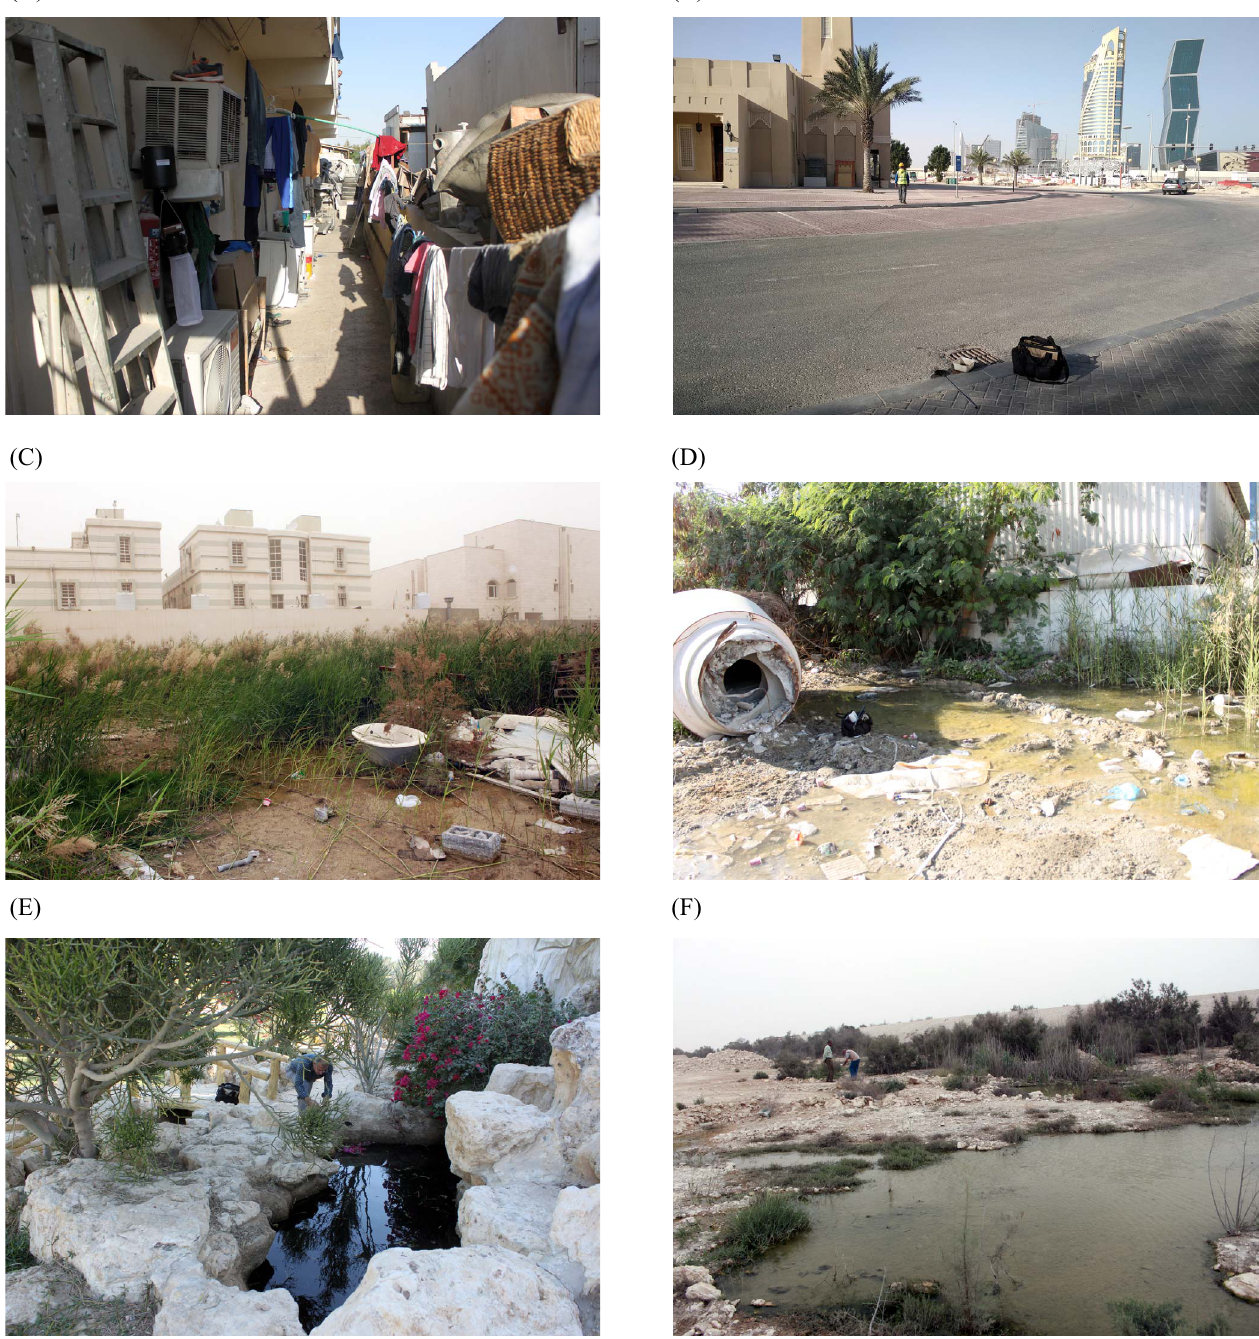
Figure 2. Examples of sites inspected for mosquitoes. A. Adult trapping at worker house, EVS trap (Q17c). Mosquito larval breeding sites: B. Road drain, breeding site for Culex quinquefasciatus (Q13); C. Flooded land in urban habitat, breeding site for Anopheles stephensi , Culex perexiguus , Culex quinquefasciatus , Culex tritaeniorhynchus (Q09); D. Flooded land in an industrial zone, breeding site for Anopheles stephensi , Culex perexiguus , Culex quinquefasciatus (Q16); E. Man-made container, positive for Anopheles stephensi , Culex quinquefasciatus , Culiseta longiareolata (Q14b); F. Wetland, breeding site for Aedes caspius , Anopheles stephensi , Culex perexiguus , Culex pusillus , Culex quinquefasciatus